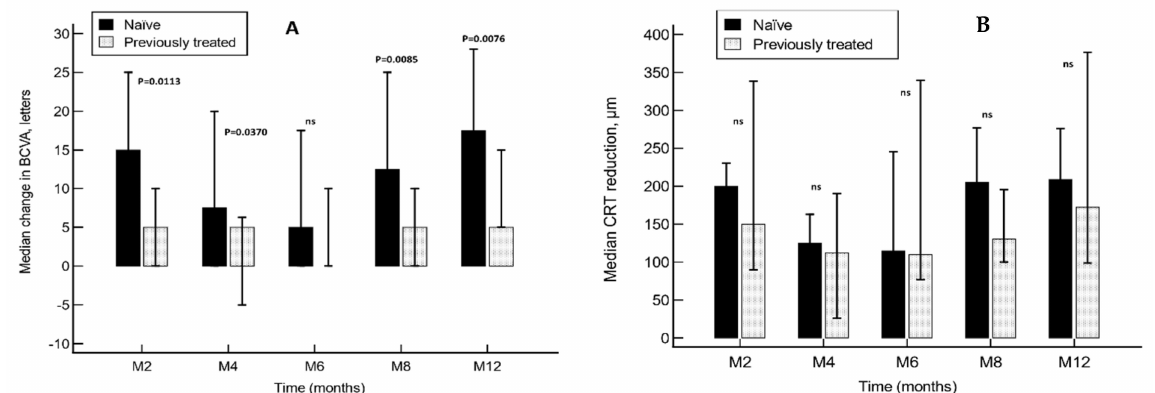
Figure 1. Median change in best-corrected visual acuity ( A ) and central retinal thickness ( B ) in treatment-naïve and previously treated eyes. Vertical bars represent interquartile range. CRT reduc- tion is shown in absolute value. ns: not significant; BCVA: best-corrected visual acuity; CRT: central retinal